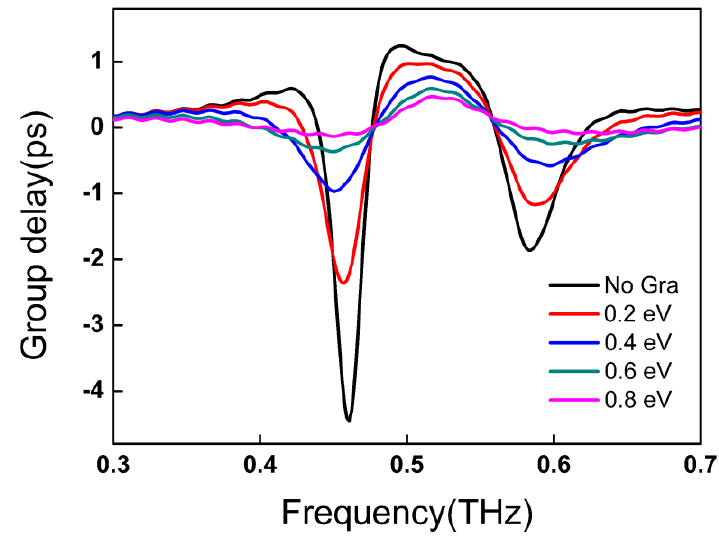
Figure 6. The group delay of the incident terahertz wave with different Fermi energies.